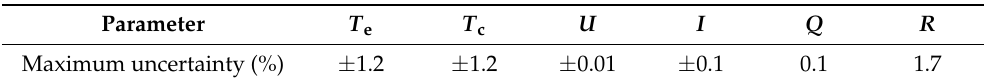
Table 3. Maximum uncertainty of the main measurement